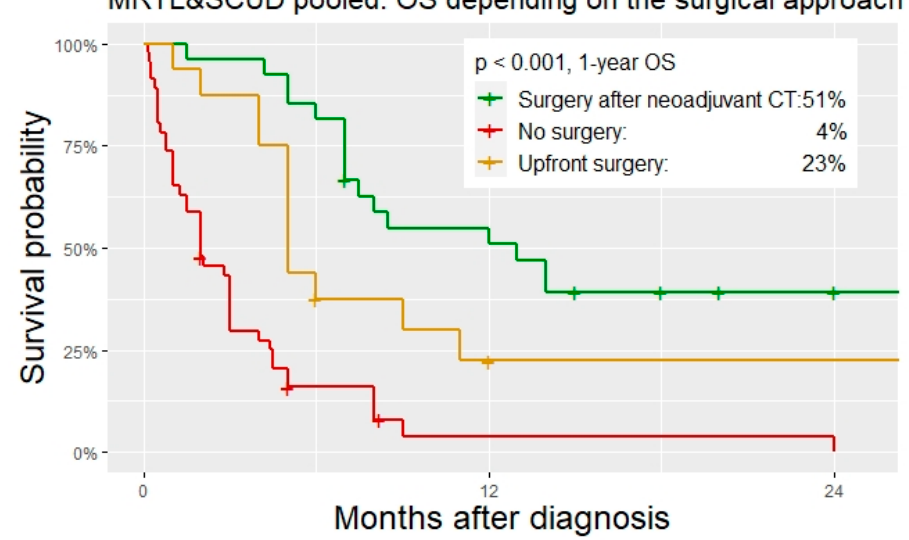
Figure 6. OS of the pooled group (MRTL and SCUD) for different surgical approaches.